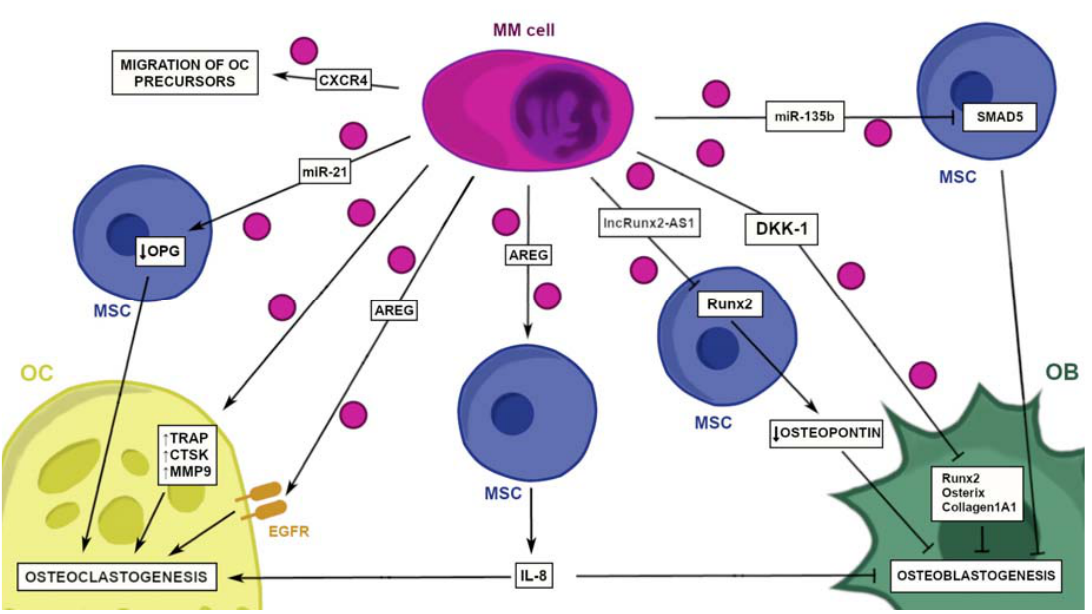
Figure 3. The influence of MM-EVs on osteolysis and bone formation. Induction of osteolysis ap- pears to be one of the roles of MM-EVs. MM-EVs have been shown to reinforce the advantage of OCs in the imbalance of OCs and OBs. When incorporated by BM-MSCs, a component of MM- EVs, miR-135b, downregulates SMAD5, a protein which, together with BMPs, is responsible for the process of osteogenesis. The downregulation of SMAD5 disturbs the process of osteogene- sis. DKK-1, an inhibitor of the Wnt signaling pathway is another component of MM-EVs. When incorporated by the osteoblast precursors, DKK-1 blocks the Wnt pathway and leads to the dimin- ished expression of Runx2, osterix and collagen1A1, resulting in the disturbance of osteogenesis. lncRunx2-AS1 integrated by BM-MSCs targets the gene Runx2 and downregulates it. This results in the downregulation of the osteopontin expression and eventually leads to the inhibition of osteo- genesis. Another important component of MM-EVs is AREG, a ligand of EGFR. It activates EGFR in the osteoclast precursors, leading to their differentiation into mature OCs. It also promotes the secretion of osteoclastogenic cytokines, such as IL-8 from BM-MSCs. Another pathway in which MM-EVs promote osteolysis is linked to the balance between RANKL and OPG. miR-21, found in MM-EVs, targets the OPG gene in BM-MSCs and lowers its expression. This leads to the imbalance of RANKL/OPG and leads to osteoclastogenesis. MM-EVs have also been shown to contribute to